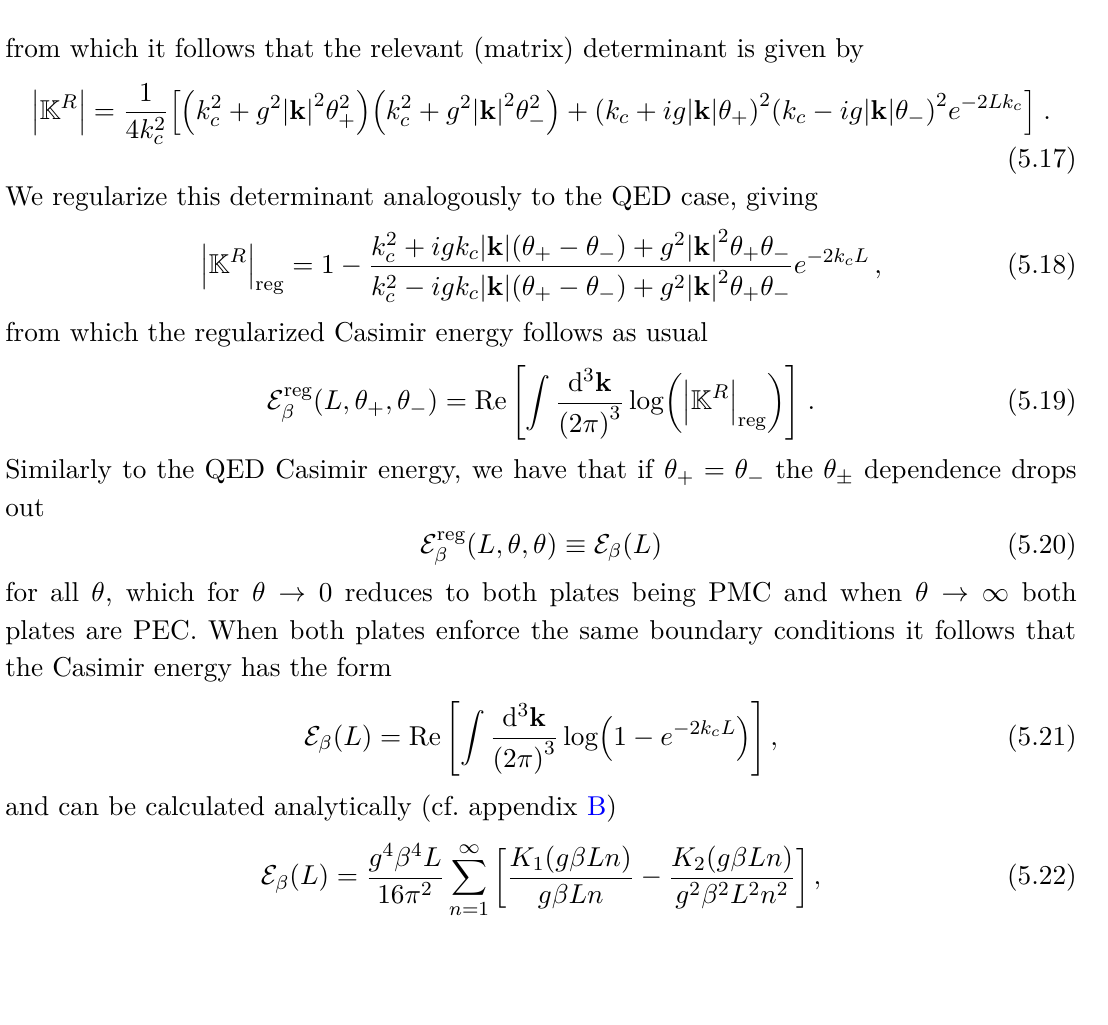
Figure 2 . The relative Casimir force e F qed The relative Casimir force only depends on the difference between the duality angles. The dotted horizontal line corresponds to e F = − 7 transitions from being attractive to